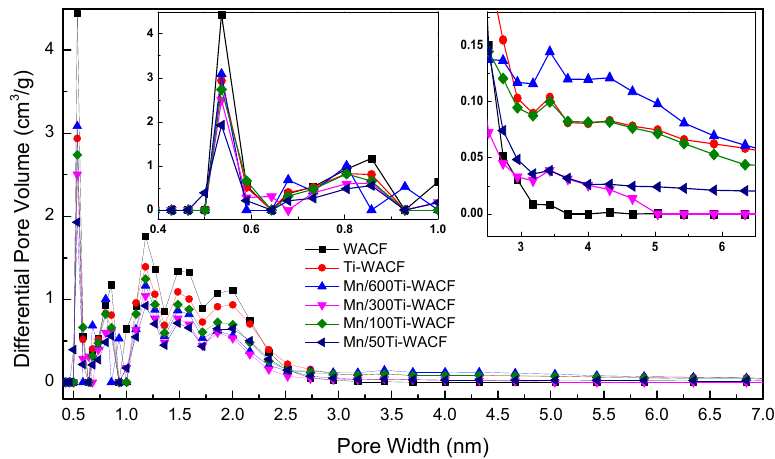
Figure 5. Pore size distribution (density functional theory method) of WACF and Mn/TiO 2 –WACF. Specific surface area, pore volume, and pore radius of the samples are shown in Table 2.